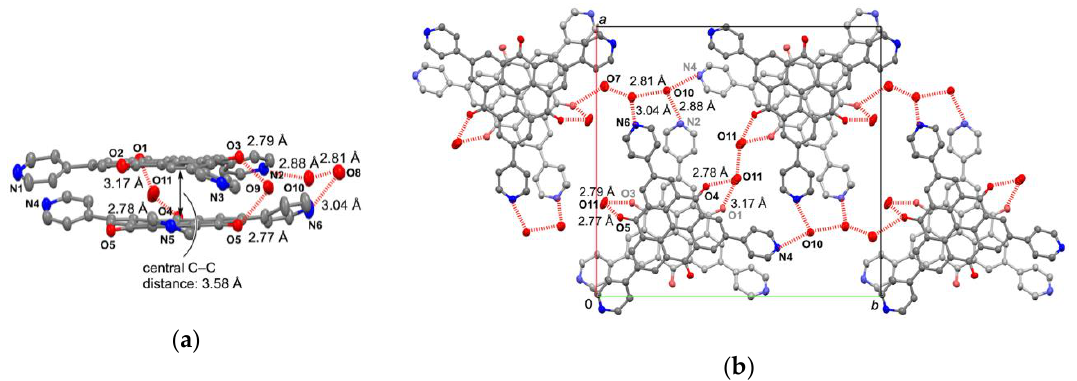
Figure 1. Crystal structure of the weak π -dimeric structure of [( n -Hex) 4 N + ]( 4 − ). ( a ) Side view; ( b ) hydrogen-bonded network of 4 − and water molecules, and overlap pattern. Color code: carbon (gray), nitrogen (blue), oxygen (red).